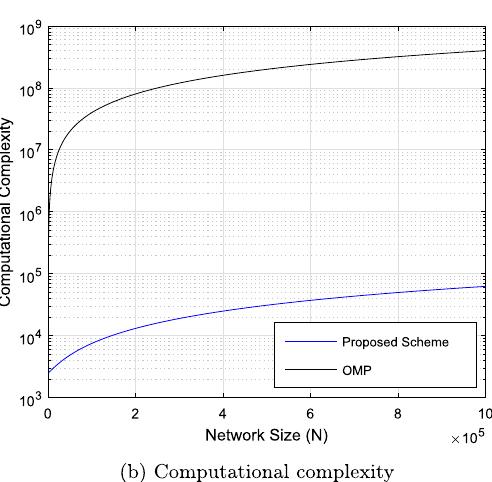
Fig. 3 Performance comparison between the proposed scheme and standard OMP with Gaussian